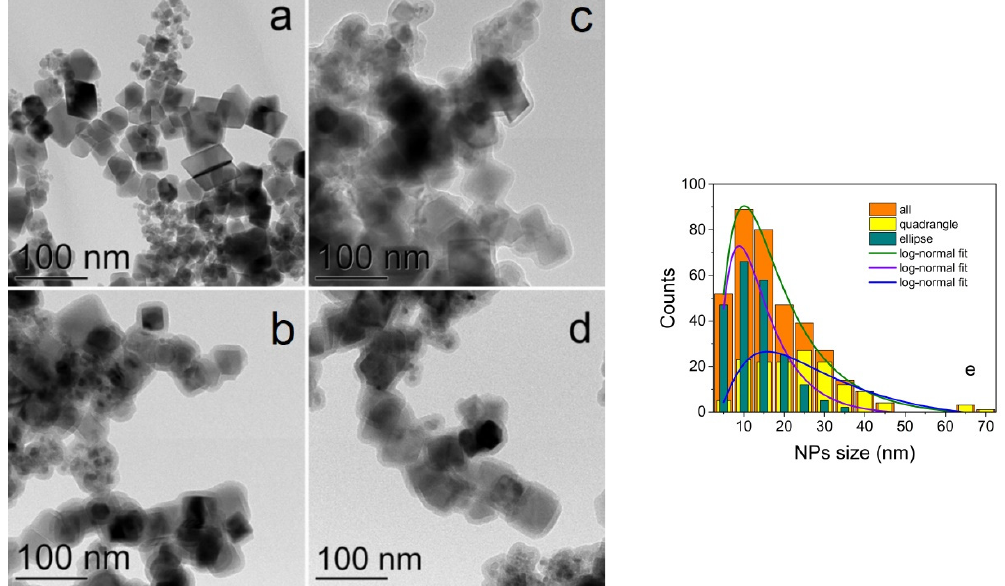
Figure 2. TEM images of Fe 3 O 4 ( a ), Fe 3 O 4 @SiO 2 ( b ), Fe 3 O 4 @SiO 2 -NH 2 ( c ) and Fe 3 O 4 @SiO 2 -NH 2 -EY ( d ) NPs. Size distribution of Fe 3 O 4 NPs ( e ).